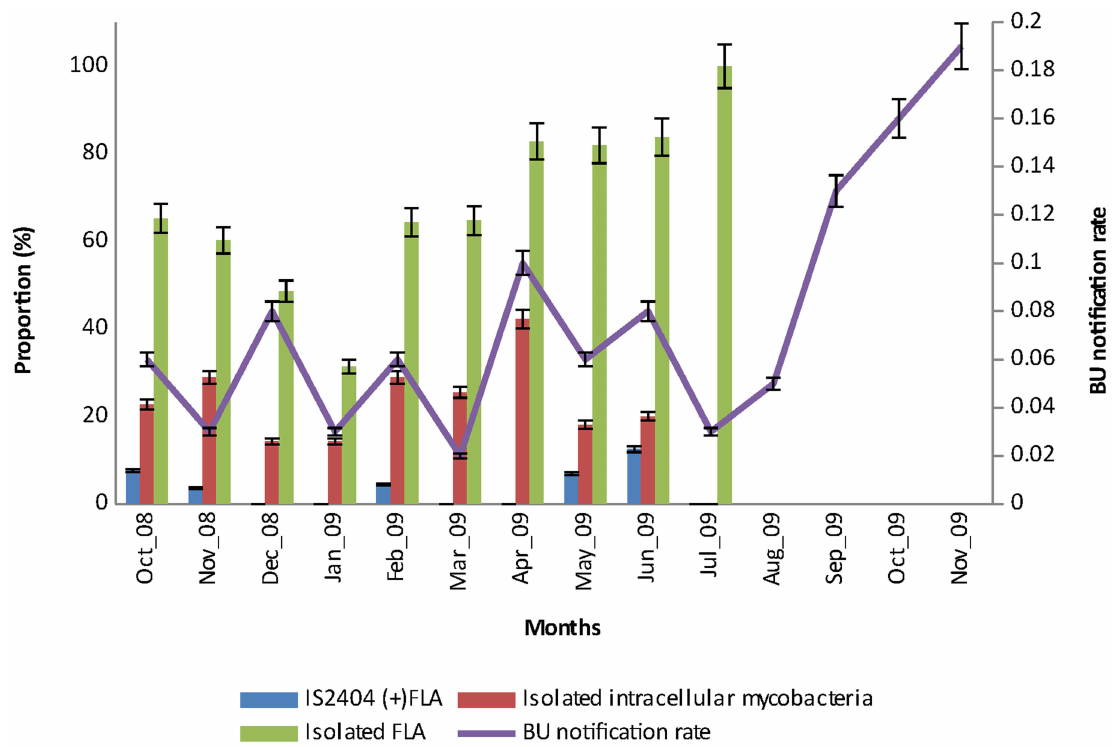
Figure 2. Proportions of FLA isolated from specimens, IS 2404 detected in FLA cultures, mycobacteria isolated from an intracellular source over the sampling period (October 2008–July 2009) and BU notification rate until four months after the sampling period. Error bars on the left Y-axis represent 95% confidence interval (CI) of the proportions of isolated FLA (68.3 6 1.66), IS 2404 detected in FLA cultures (3.5 6 0.37) and intracellular mycobacteria (21.49 6 0.95) sampled monthly from environmental specimens (n=539) for the specified period. Error bars on the right Y-axis represent the 95% CI of BU notification rate of the 5 endemic communities (0.08 6 0.04) with a population size of 6,296. doi:10.1371/journal.pntd.0003148.g002 PLOS Neglected Tropical Diseases |